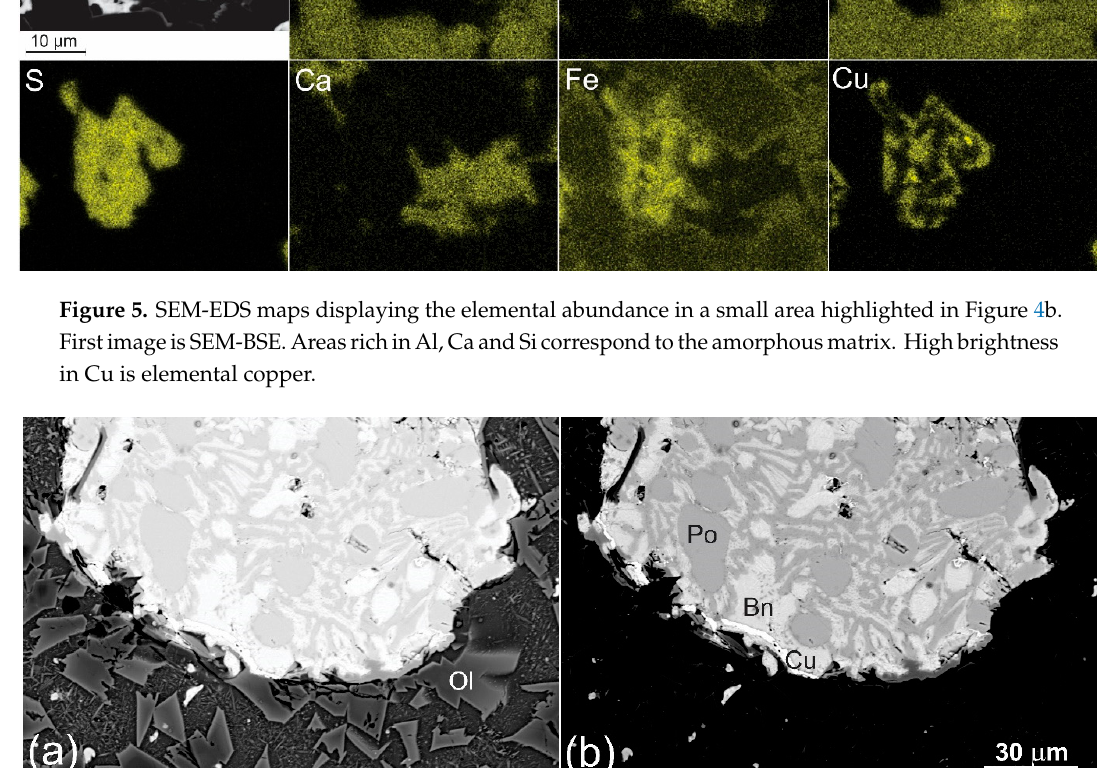
Figure 6. SEM-BSE images of a sample of non-magnetic slag (Figure 2e). Cu-Fe sulfide nodule (bright) composed of pyrrhotite (Po), bornite (Bn) and elemental copper (Cu, white line) in a matrix of zoned prismatic olivine (Ol) crystals. Both images are of the same area and the same magnification (scale in (b) applies to both figures) but ( a ) is at high brightness to emphasize olivine microstructure and ( b ) at lower brightness to display complex intergrowth structures of sulfides.